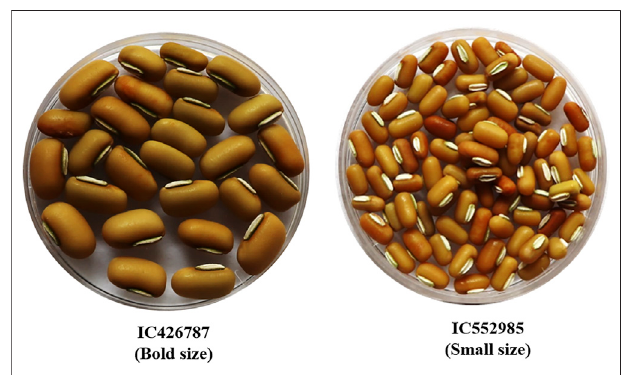
FIGURE 1 | Two contrasting genotypes of ricebean, that is, IC426787 (bold size) and IC552985 (small size), selected for the transcriptome analysis on the basis of their seed